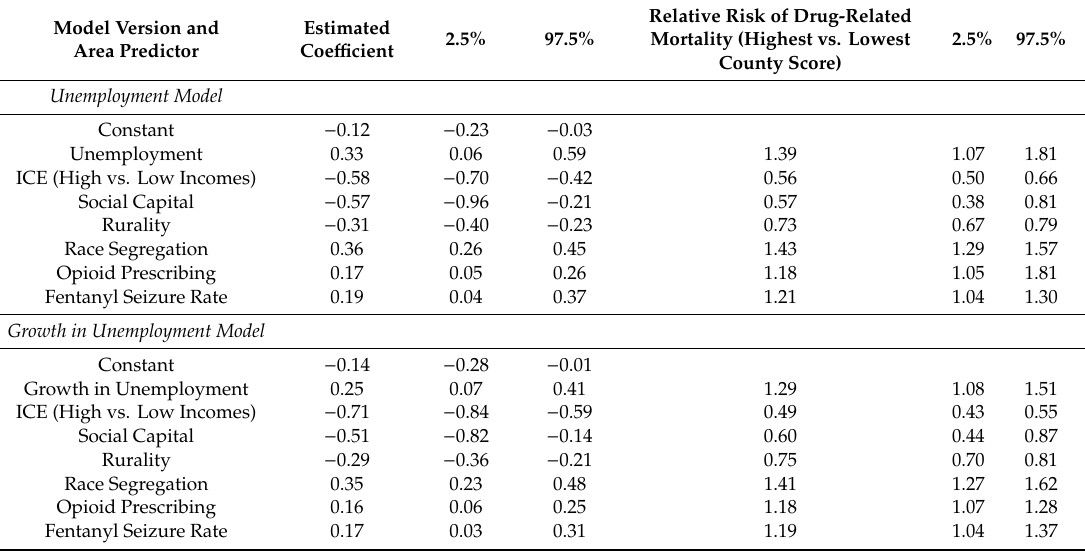
Table 1. Covariate e ff ects. Coe ffi cients and relative